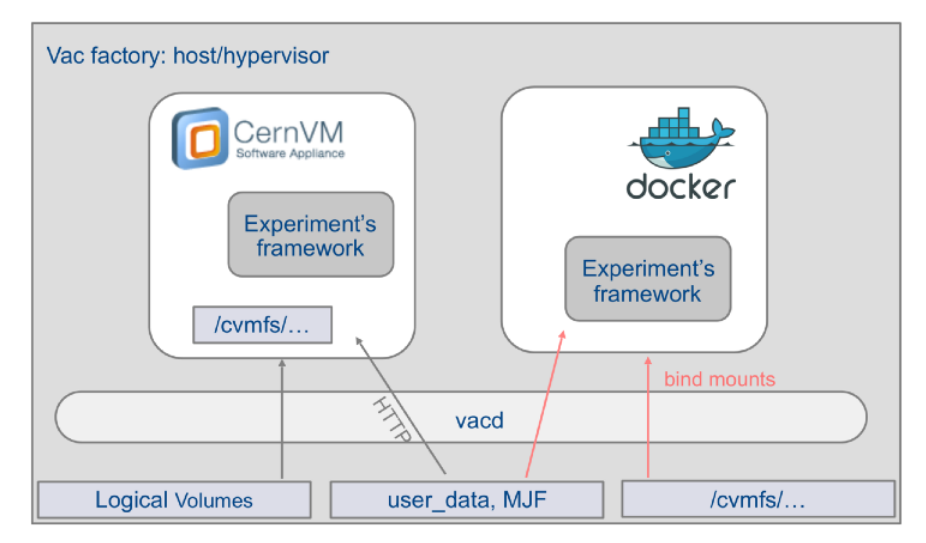
Fig. 1. VMs and Docker containers, side by side, on a Vac